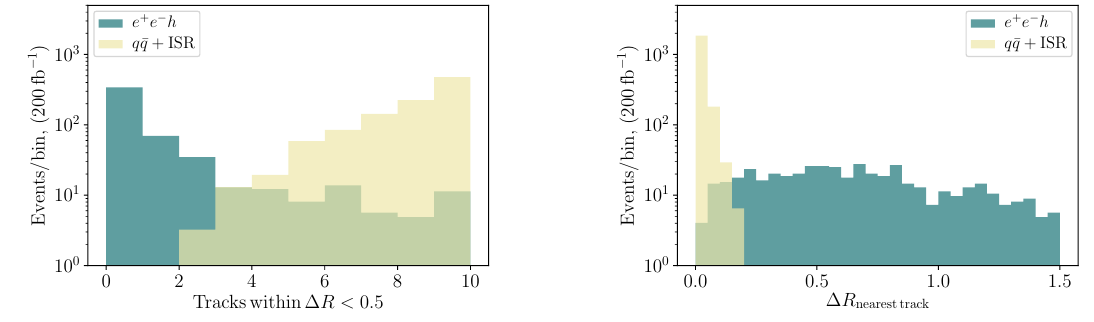
Figure 5 . Track isolation information for the Z ( e + e (cid:0) ) h signal and q (cid:22) q + ISR background for ! 200 fb (cid:0) 1 of integrated luminosity. The distribution on the left shows the total number of charged tracks with p T > 0 : 5 GeV within a cone of (cid:1) R = 0 : 5 around a track based electron candidate passing all other cuts (including the m reco window requirement). Note that all such track based electron candidates in the q (cid:22) q +ISR background with 200 fb (cid:0) 1 of integrated luminosity have at least two charged tracks within (cid:1) R < 0 : 5, re(cid:13)ecting the non-trivial track multiplicity of QCD jets that is not present for isolated electrons. The distribution on the right shows the distance between the least isolated electron candidate and the nearest charged track with p T > 0 : 5 GeV. Genuine electrons tend to be more isolated, whereas the track based electron candidates in the q (cid:22) q + ISR background with 200 fb (cid:0) 1 of integrated luminosity always have another charged track within (cid:1) R . 0 :